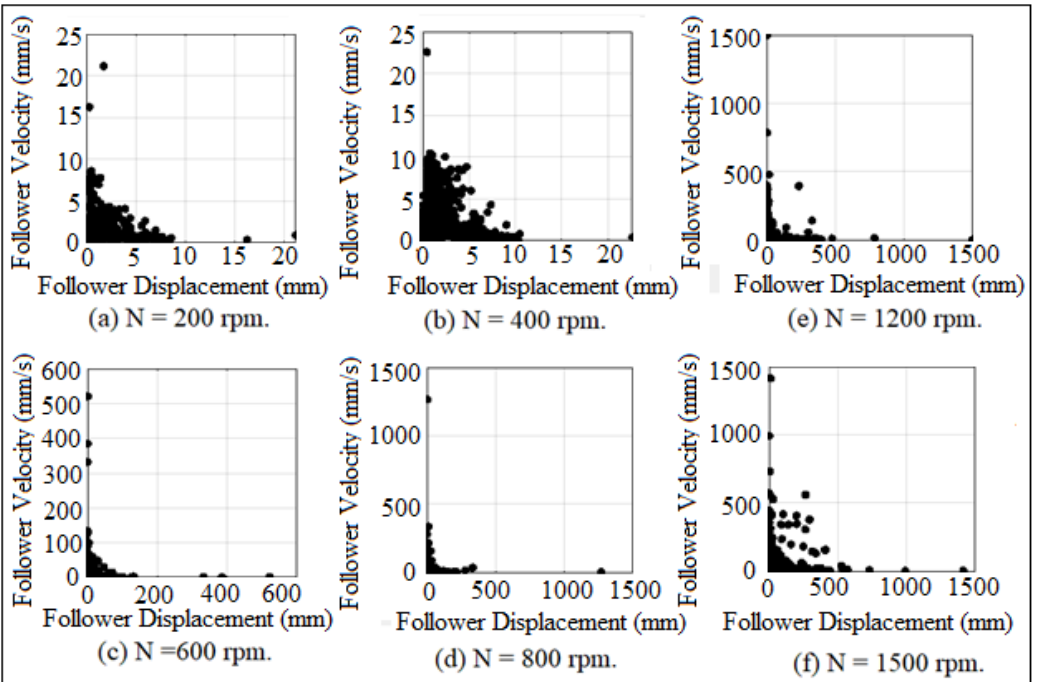
Figure 42. Poincare’ maps for (I.D. = 19 mm) at different cam speeds.